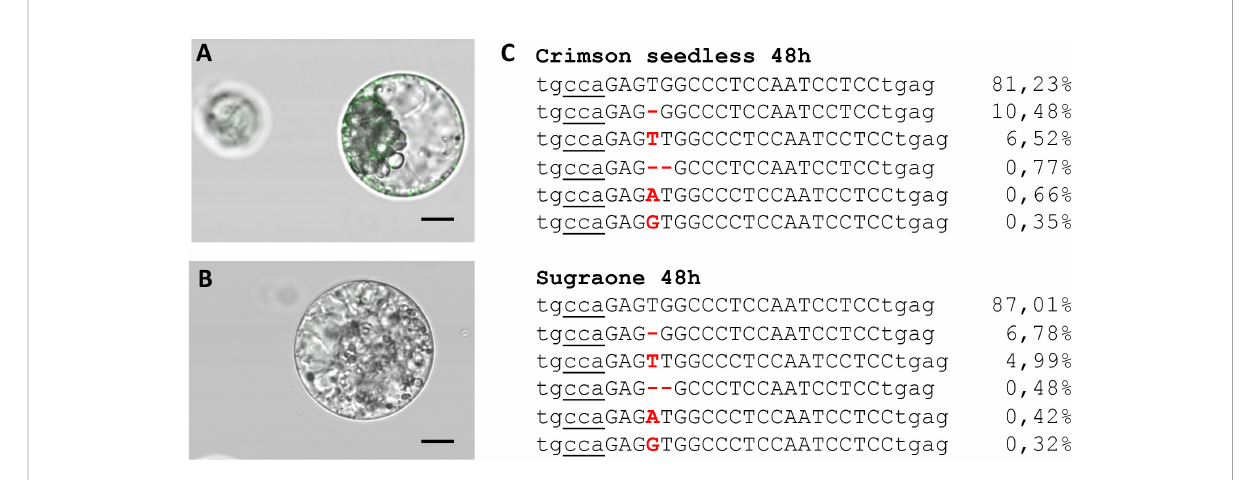
FIGURE 4 Transient transfection of protoplasts. (A) Image taken 2 h after transfection with Cas9-GFP RNPs ( fl uorescent endocytosis vesicles are visible) and (B) negative control. (C) Amplicon deep sequencing of DNA extracted from protoplast populations of Crimson s. and Sugraone at 48 h after transfection with RNPs with guide RNA targeting VviDMR6 . The total amount of reads was 43828 and 53995, respectively, and the percentage of edited and wild-type ( fi rst raw in the alignment) reads is